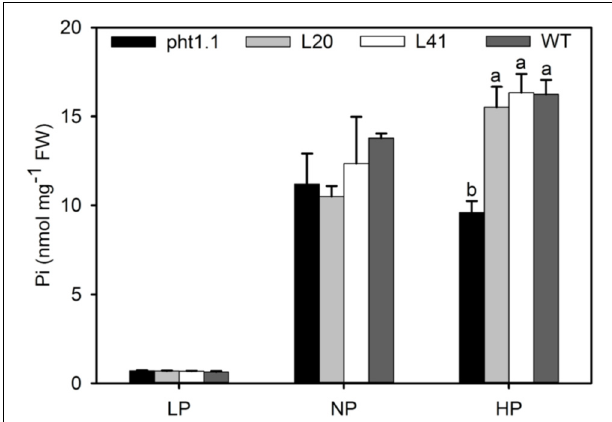
FIGURE 6 | Phosphate concentrations of shoots of different lines under various phosphate levels. Effect of MtPT6 on phosphate concentration of Arabidopsis knockout mutant pht1.1 . LP, low inorganic phosphate (Pi) concentration treatment (5 µ M); NP, normal Pi concentration treatment (130 µ M); HP, high Pi concentration treatment (1 mM). Bars represent the mean ± SE ( n = 3). Different letters represent significant differences according to Duncan’s test ( P <